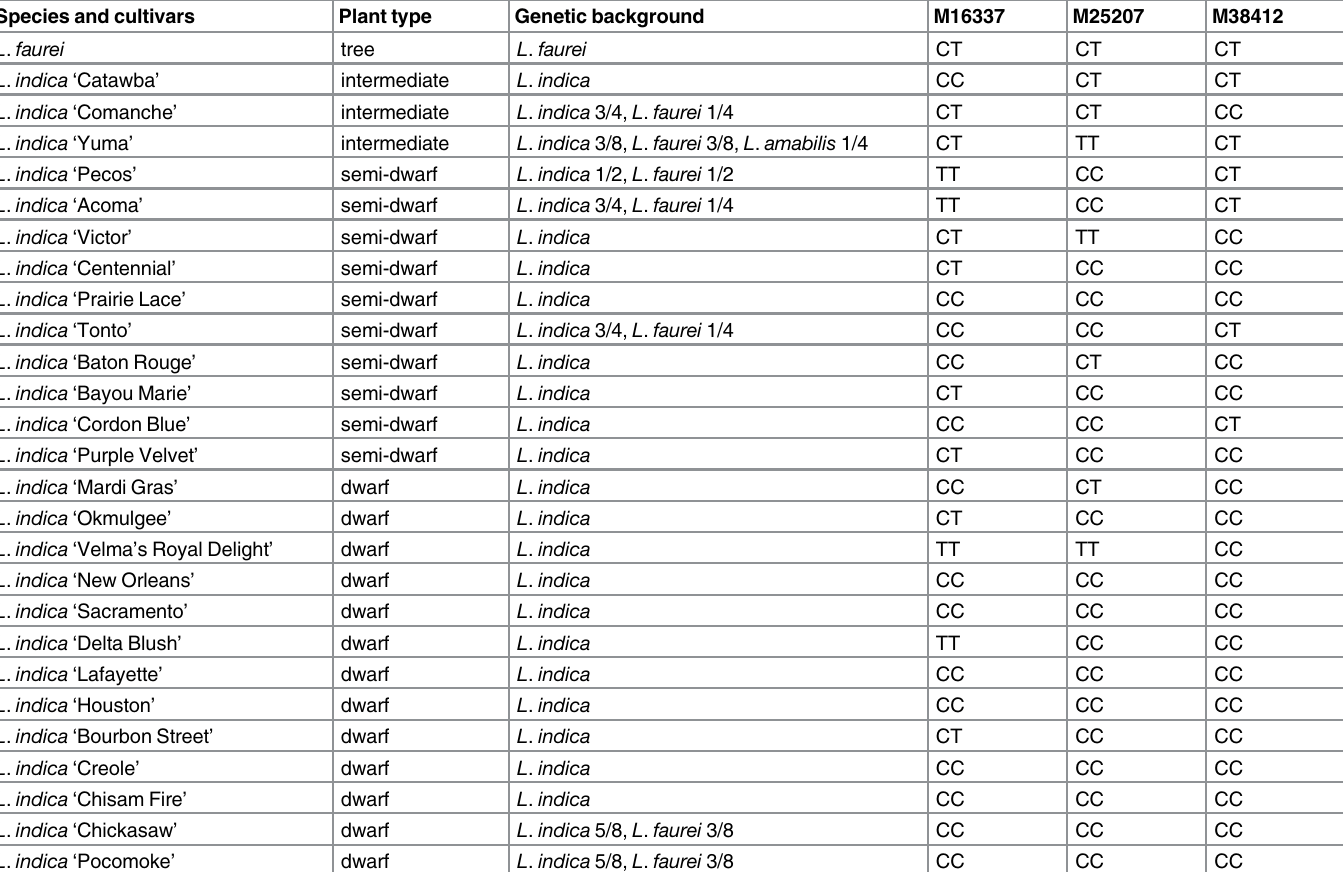
Table 7. Testing the SNP markers in a set of 28 Lagerstroemia stocks with diverse plant architectures. Species and